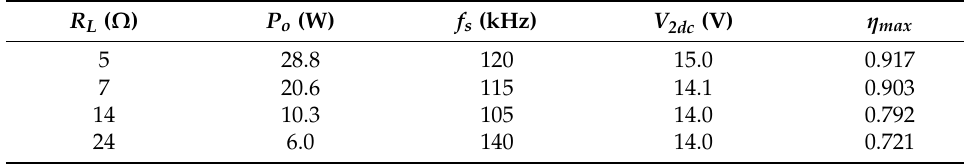
Figure 26. Average experimental efficiency vs. output power P o (red circles) with error bars indicating the minimum and the maximum efficiency points. Table 8. Maximum efficiency points achieved for the analyzed load conditions.